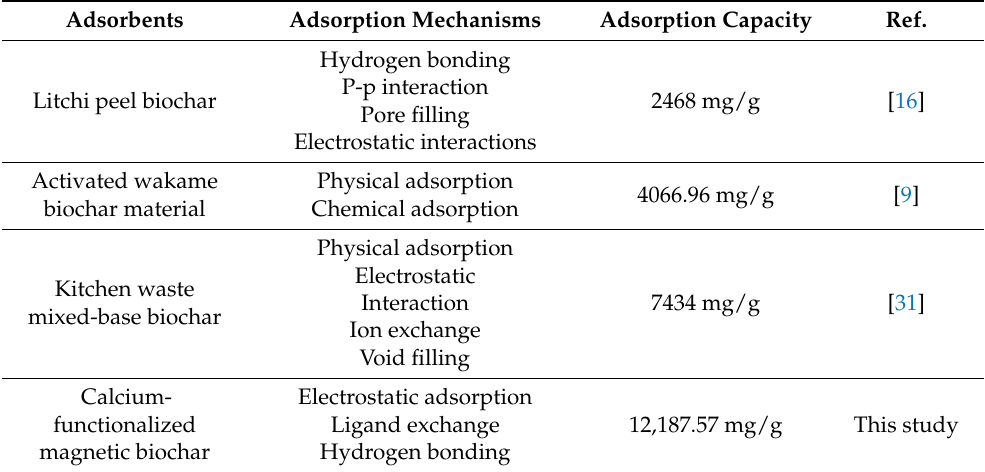
Table 1. Comparison of MG adsorption capacities on various